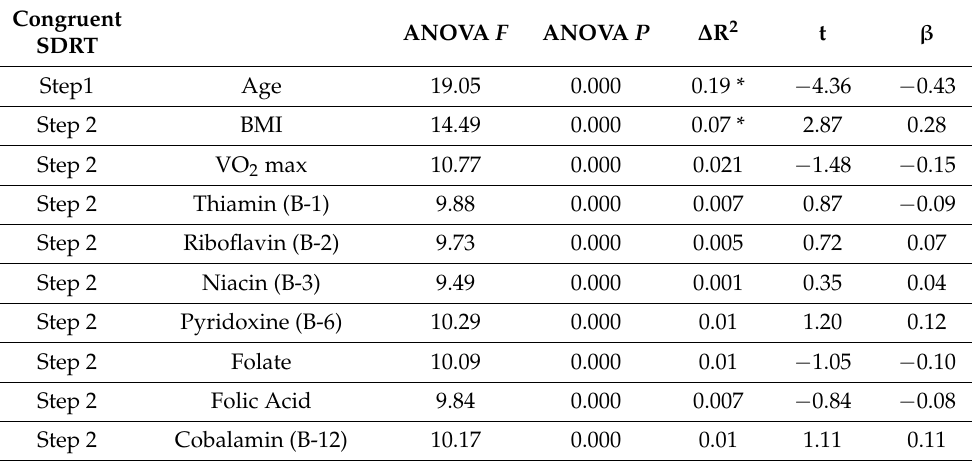
Table 7. Congruent Standard Deviation of Reaction Time